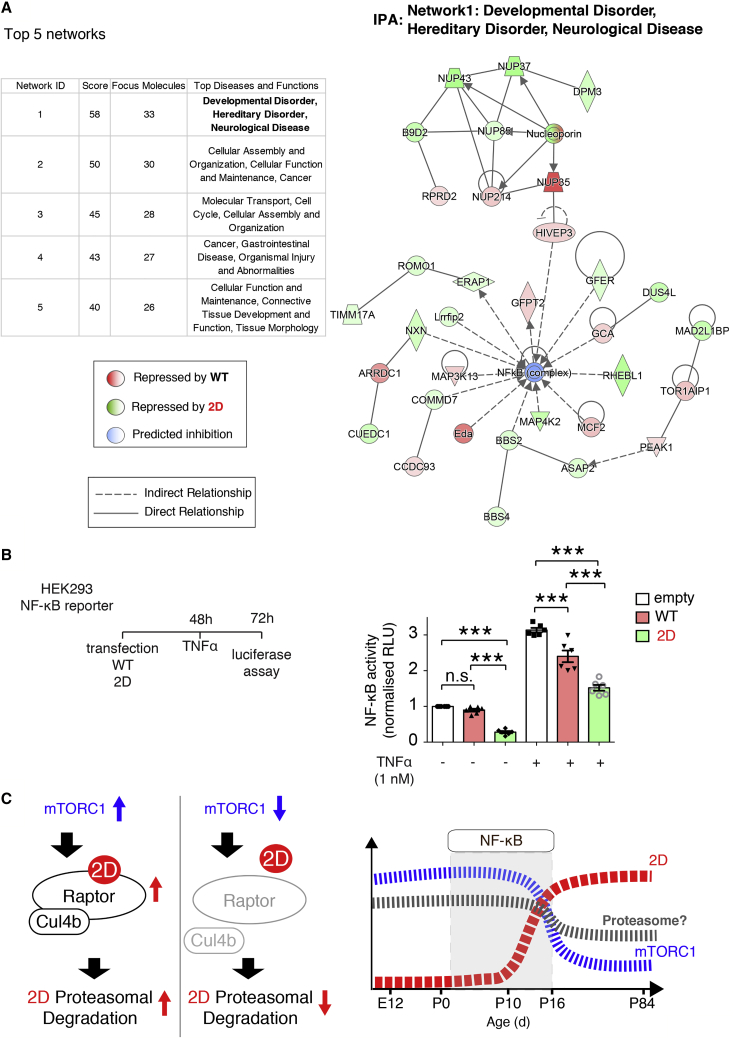
4E-BP2-Mediated Translational Control Regulates NF-κB Activity(A) Left: IPA of ribosome-profiling DTGs from Figure 5 with the molecular activity predictor (MAP) analysis tool. The top five scoring networks are shown. Right: detailed node graph of the top scoring network—developmental disorder, hereditary disorder, and neurological disease—in which NF-κB is the central node. Direct and indirect relations between nodes are shown for DTGs repressed by WT (red) or 2D (green) within the predicted network.(B) NF-κB reporter assay in HEK293 cells using a luciferase-based assay. Two-way ANOVA with Bonferroni’s post hoc; ∗∗∗p < 0.001, n = 6 for each group.(C) Diagrammatic summary of the mechanism described in this paper.